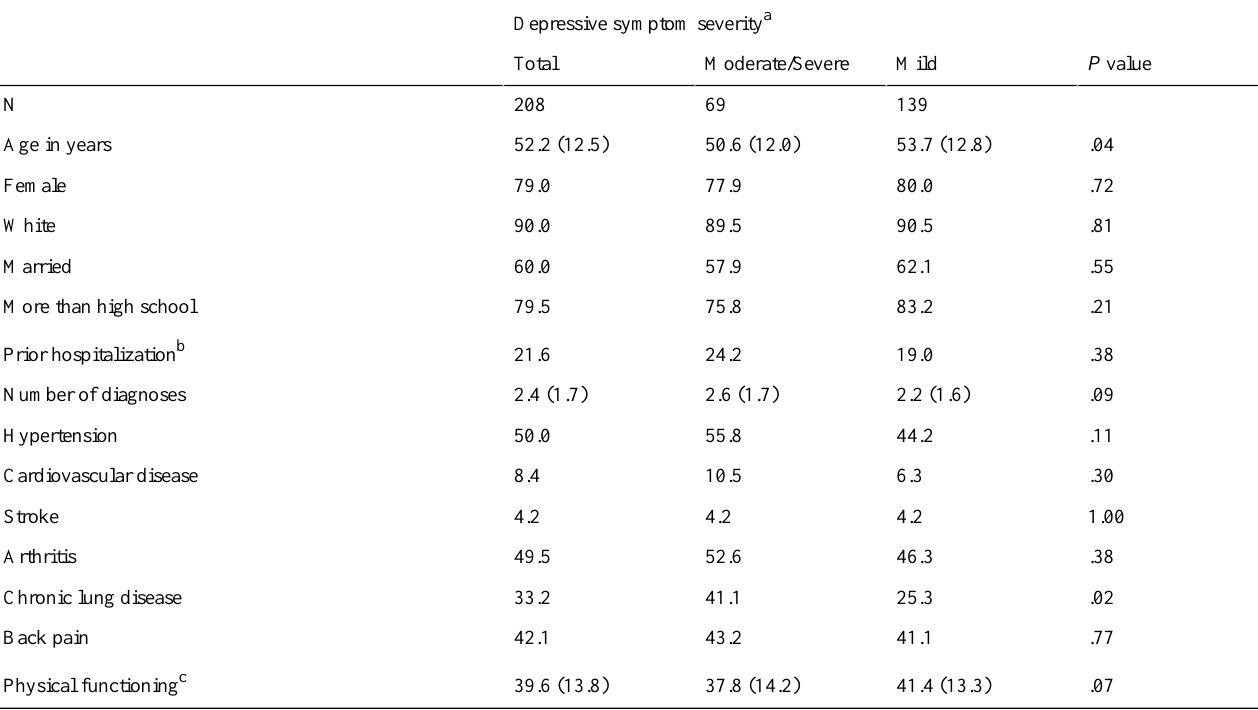
Table 1. Patient characteristics (cell entries, aside from N, are either column percent or mean [SD]).